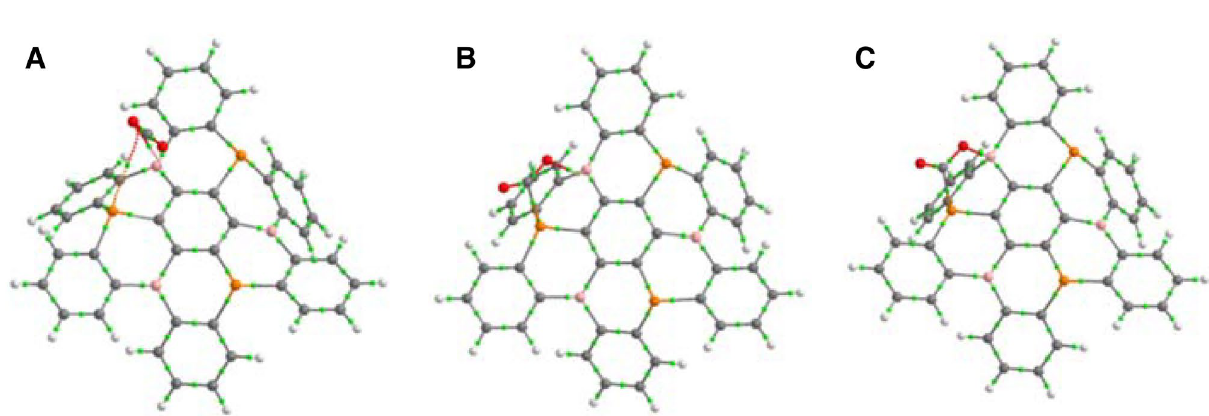
Figure 4. Reaction profile of the sequential capture of three CO 2 molecules by B 3 P 3 -NG. The energies are in kJ mol −1 and correspond to M06-2X/6-311++G(3df,3pd)//M06-2X/6-31+G* calculations.